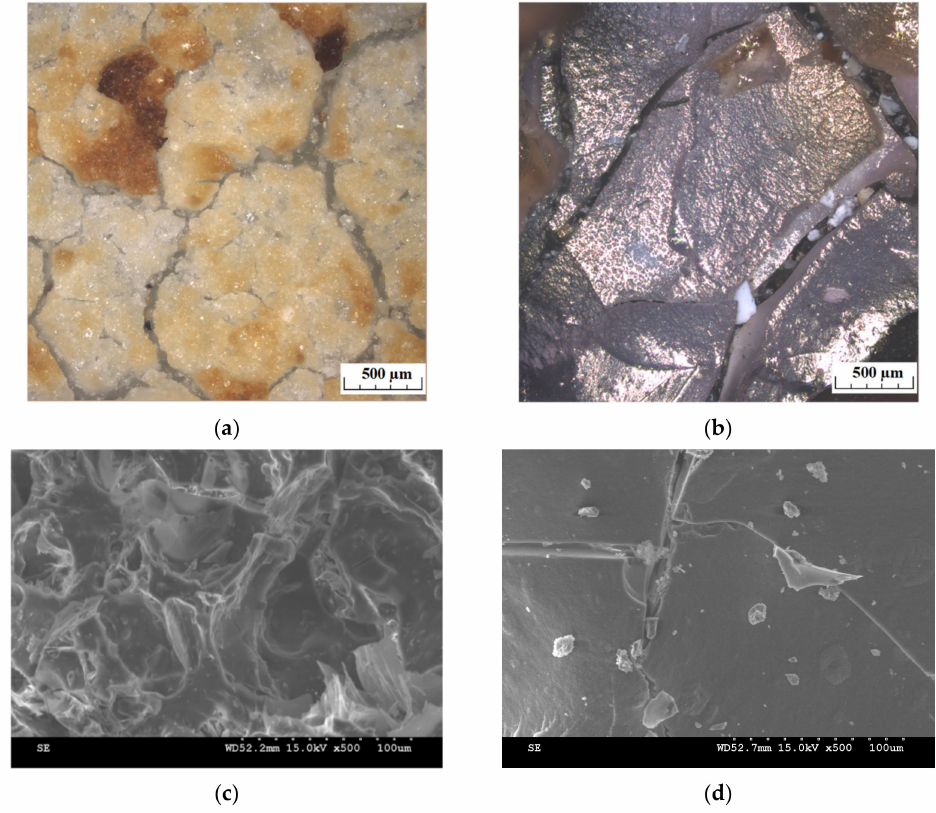
Figure 8. Microscopic images of dry-arc resistance post-tested samples at a magnification of 50 for ( a ) SiR + 10 wt% GS10 and ( b ) SiR + 5 wt% FS07 composites, and SEM imaging at a magnification of 15 k for ( c ) the SiR + 30 wt% GS10 and ( d ) SiR + 5 wt% FS07